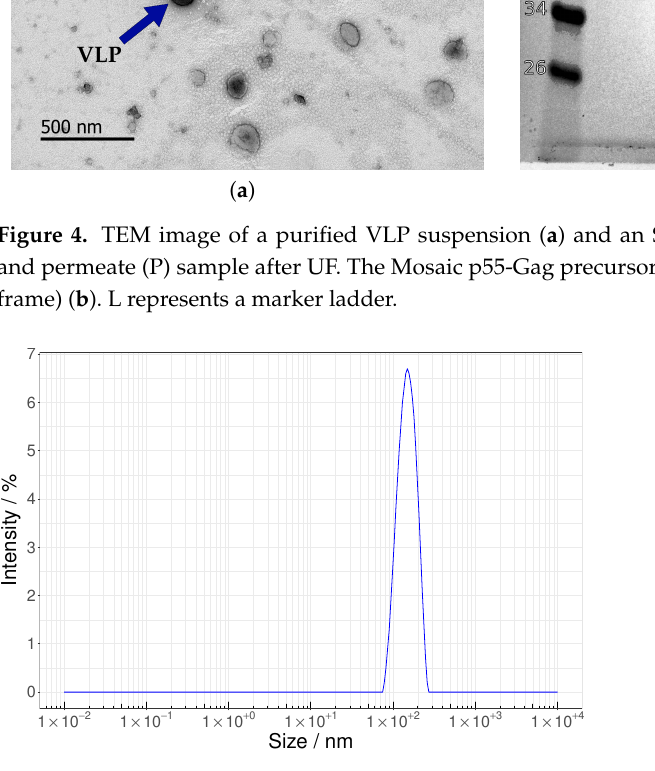
Figure 5. Particle size distribution of a VLP suspension after